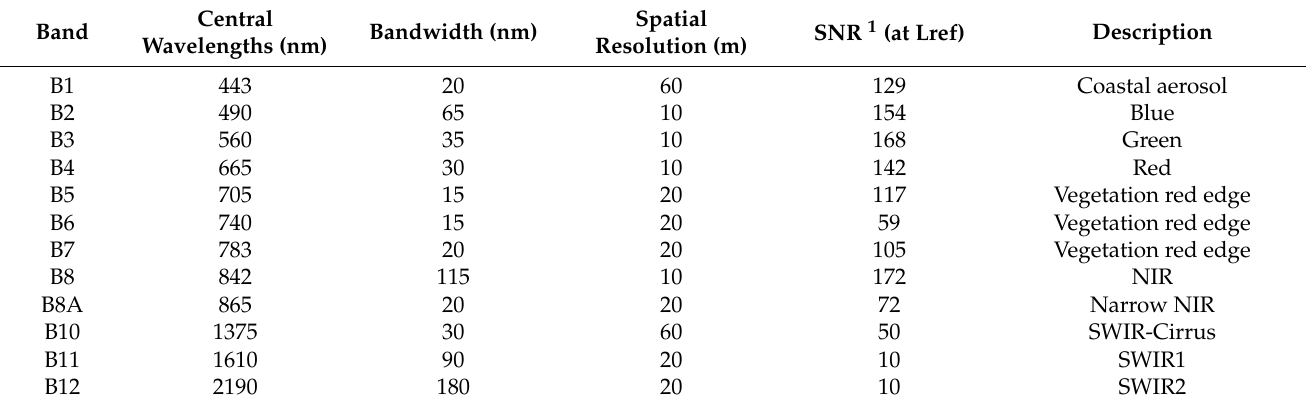
Table 1. Details of Sentinel-2 bands used in this study.